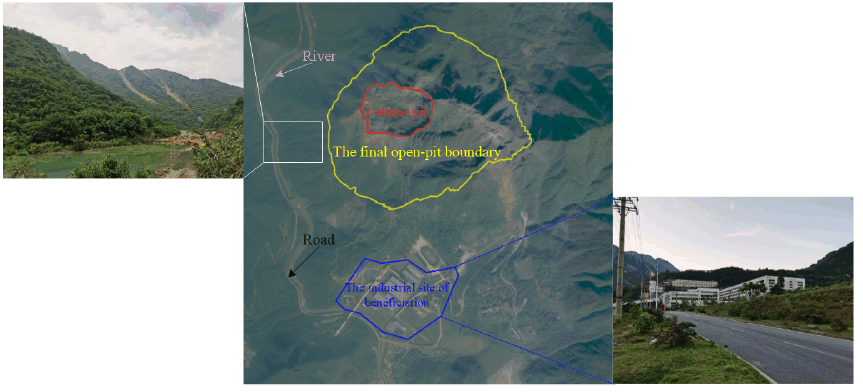
Figure 1. The satellite view of the mine site.